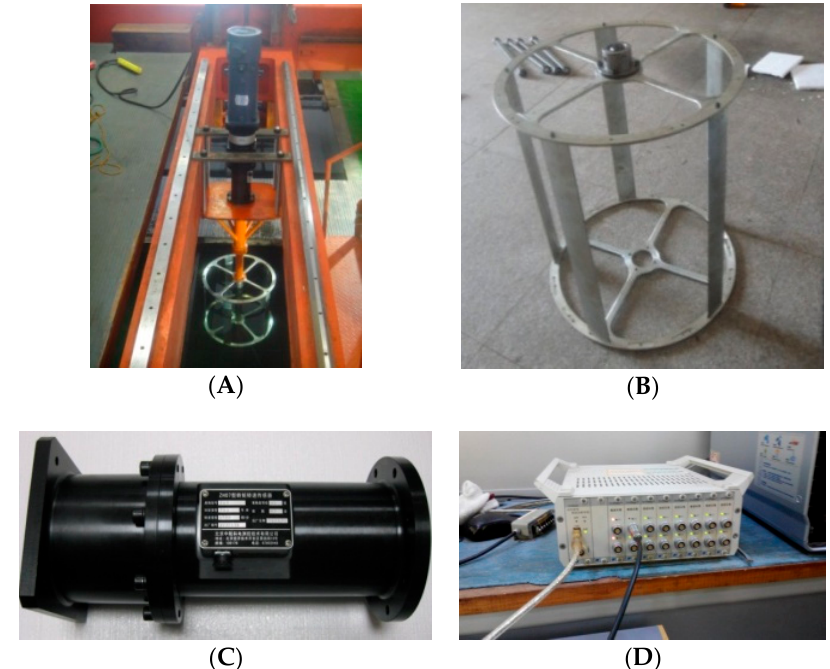
Figure 9. Apparatus used to measure the torque of a vertical-axis turbine. ( A ) Test layout; ( B ) Five-blade vertical-axis turbine model; ( C ) Torque meter; ( D ) 32-channel dynamic data acquisition instrument. Table 2. Parameters of the model test.